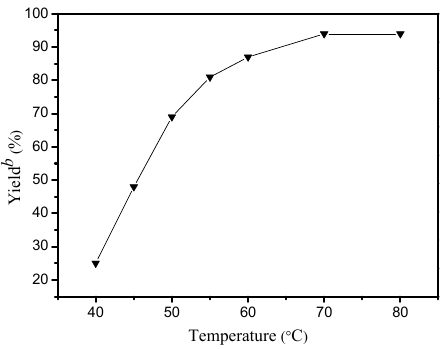
Figure 3. Reaction yields at different temperatures a . a Reaction conditions : 2-aminoacetophenone (0.3 mmol), ethyl acetoacetate (0.36 mmol), and α -chymotrypsin (10 mg) in 20% ([EMIM][BF 4 ]/(H 2 O + [EMIM][BF 4 ]), v / v ) IL aqueous solution at different temperatures for 24 h. b Isolated yield after column chromatography.